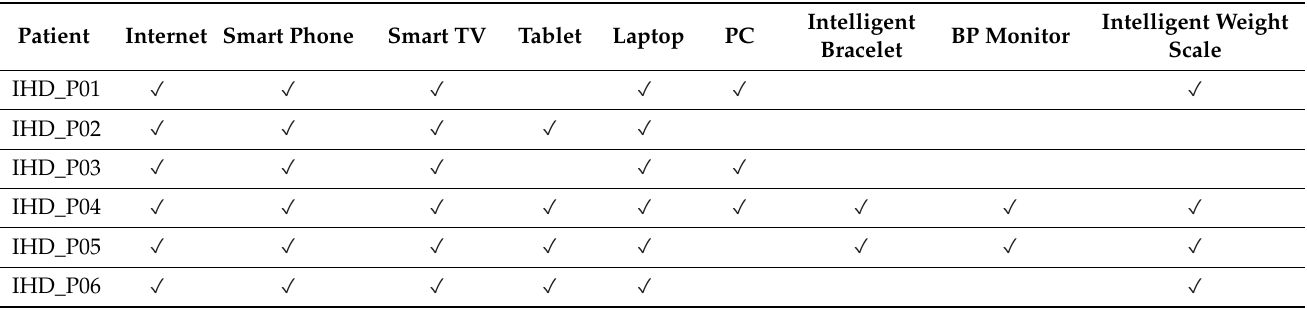
Table 3. Home technology HF patients. HF = heart failure, PC = personal computer, BP = blood pressure, ✓ = marks the devices that patients own.